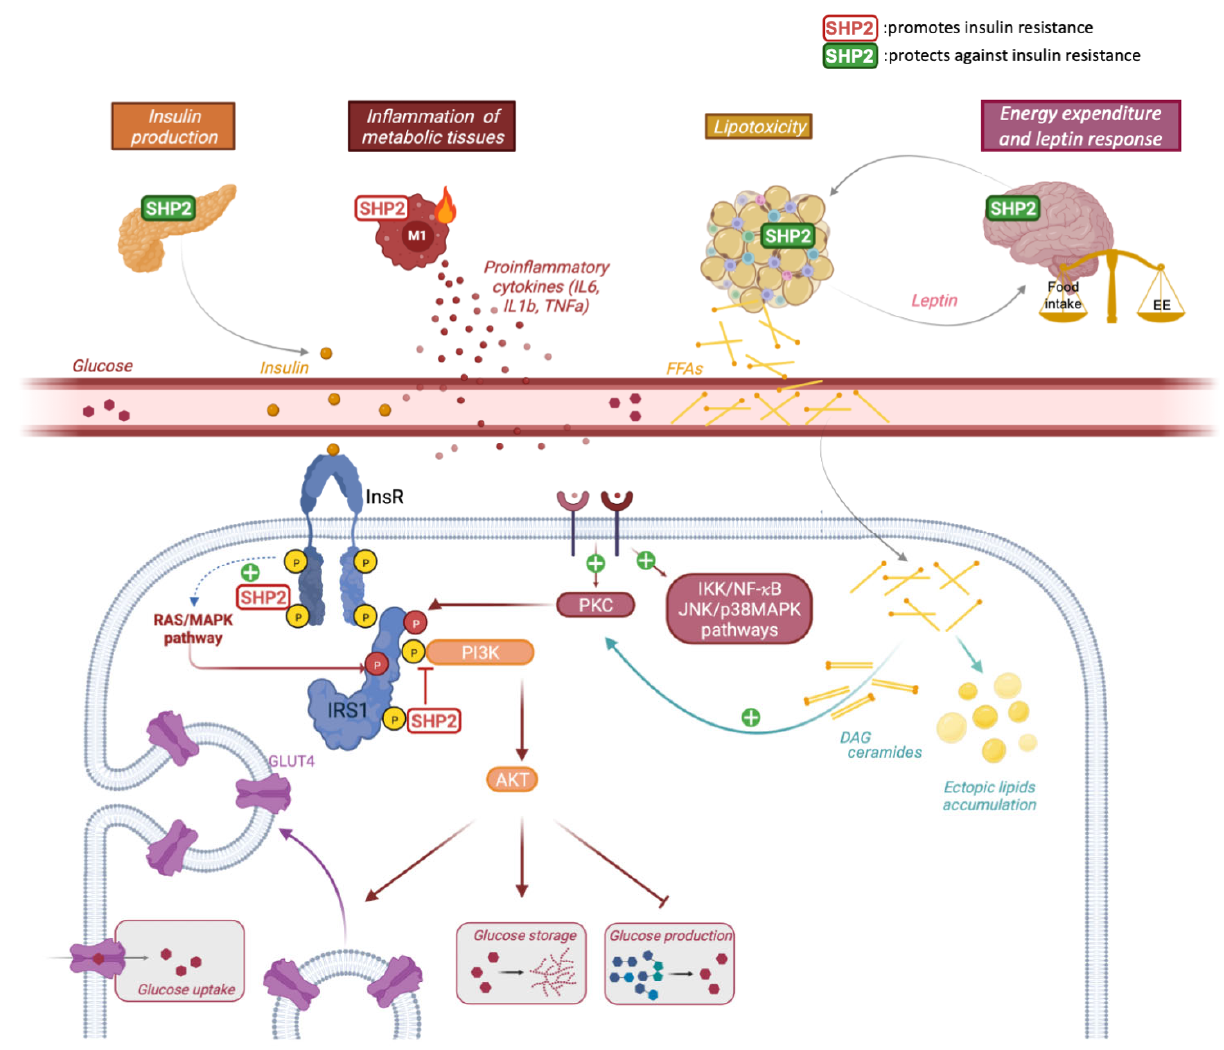
Figure 1. SH2 containing protein tyrosine phosphatase (SHP2) in insulin signaling: At the cellular level, SHP2 plays a negative role in insulin metabolic pathway by dephosphorylating phospho- inositide 3-kinase (PI3K)-binding sites (in yellow) and through RAS/Mitogen Activated Protein Kinase (MAPK)-dependent inhibitory phosphorylation (in red). This results in the downregulation of insulin-dependent glucose uptake and storage, and the increase of glucose production, notably in the liver, all contributing to hyperglycemia. In addition, SHP2 promotes a proinflammatory M1 state in macrophages, which triggers inflammation-dependent insulin resistance. On the other side, SHP2 has protective effects against insulin resistance by (i) promoting insulin biosynthesis in pancreas, (ii) regulating the development and function of adipose tissue, and (iii) stimulating central, leptin- dependent, energy expenditure. DAG: diacylglycerol, FFA: free fatty acid, InsR: insulin receptor. Created with BioRender.com accessed on 30 June 2022.